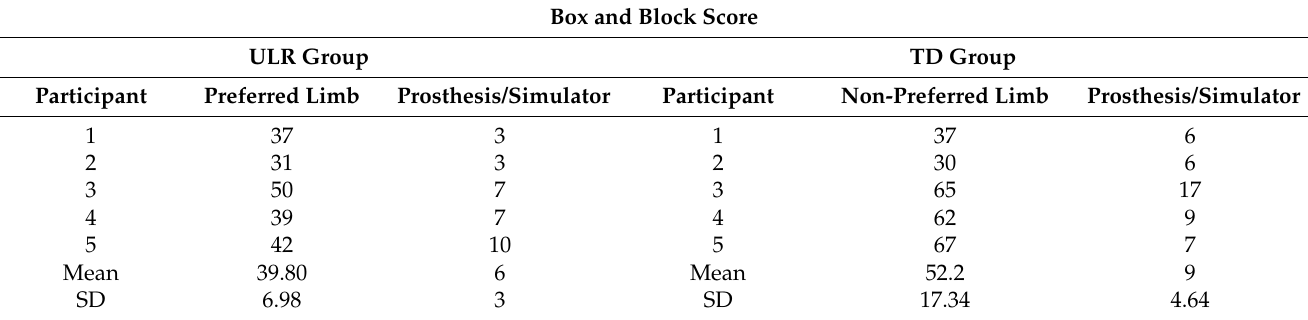
Table 2. The Box and Block score is determined by how many blocks can be moved to one side of a partitioned box to another within 1 min. Children with ULR performed the task with their non-affected limb and their prosthesis, while TD children performed the task with their non-dominant limb, with and without the simulator.